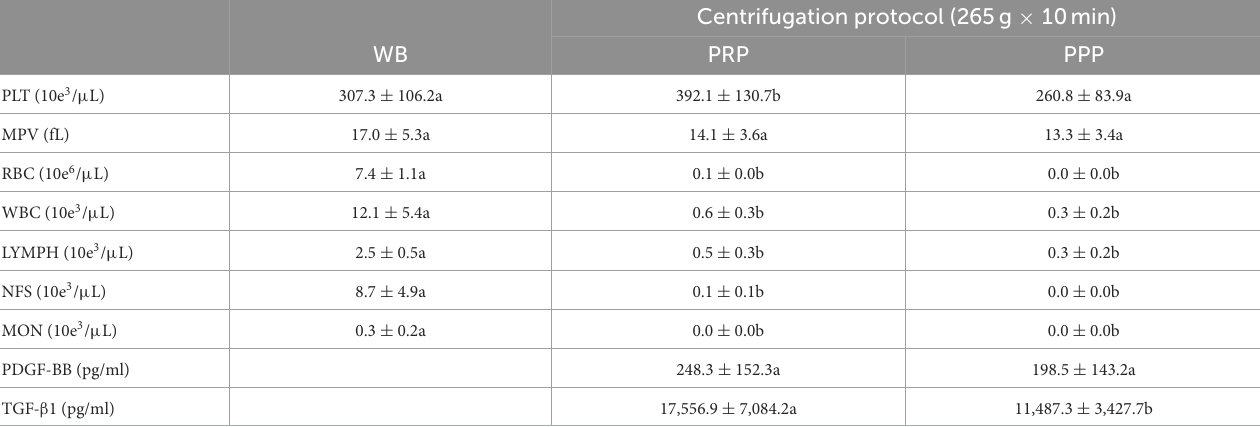
TABLE 2 Mean ± SD of platelet (PLT) concentrations, mean platelet volume (MPV), erythrocytes (RBCs), leukocytes (WBC), lymphocytes (LYMPH), neutrophils (NFS), and monocytes (MON) concentrations in whole blood (WB) samples and in the PRP and PPP fractions; platelet-derived growth factor BB (PDGF-BB) and transforming growth factor B1 (TGF- β 1) concentrations in the PRP and PPP fractions in 11 FeLV cats ( n =